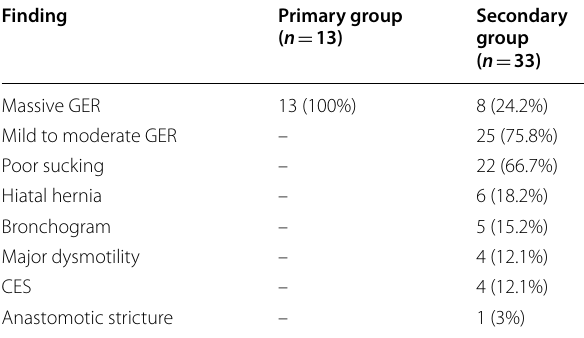
Table 5 Results of video-fluoroscopy contrast studies